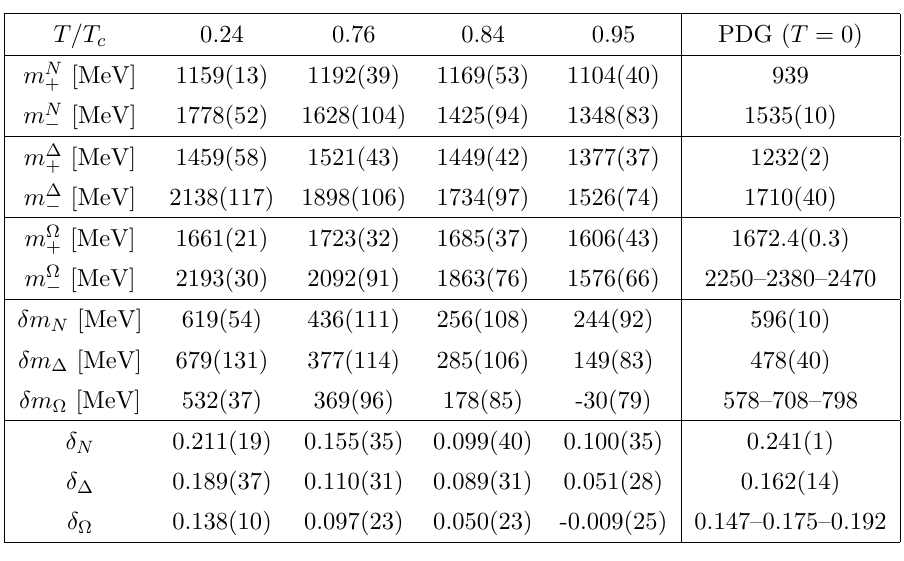
Table 2 . Groundstate masses m (cid:6) in both parity sectors in the N , (cid:1) and (cid:10) channels below T c . Estimates for statistical and systematic uncertainties are included. The (cid:12)nal column shows the T = 0 values in nature [54]. Note that there are several candidates for m (cid:10)